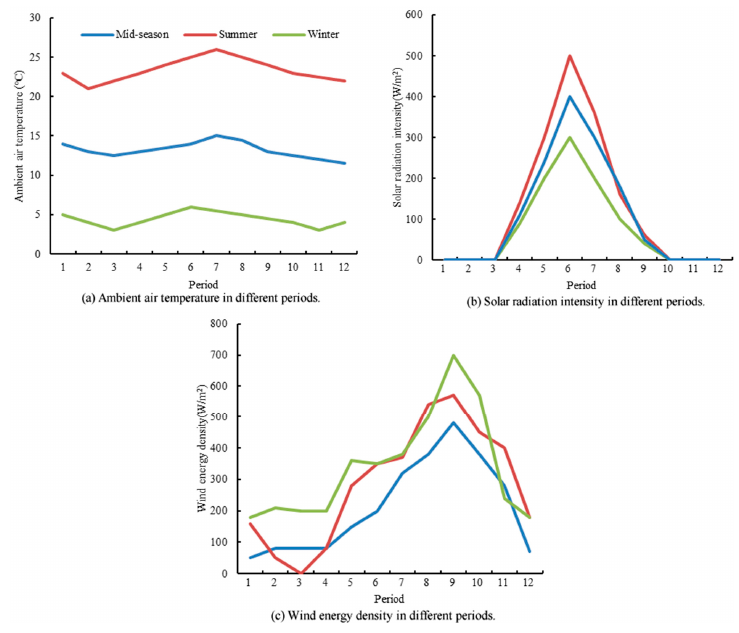
Figure 3. Environmental parameters of climate.